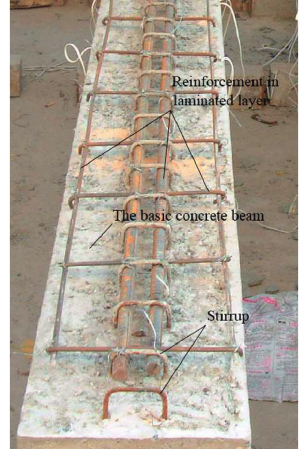
Figure 9: Chiseled basic T-shaped beams.